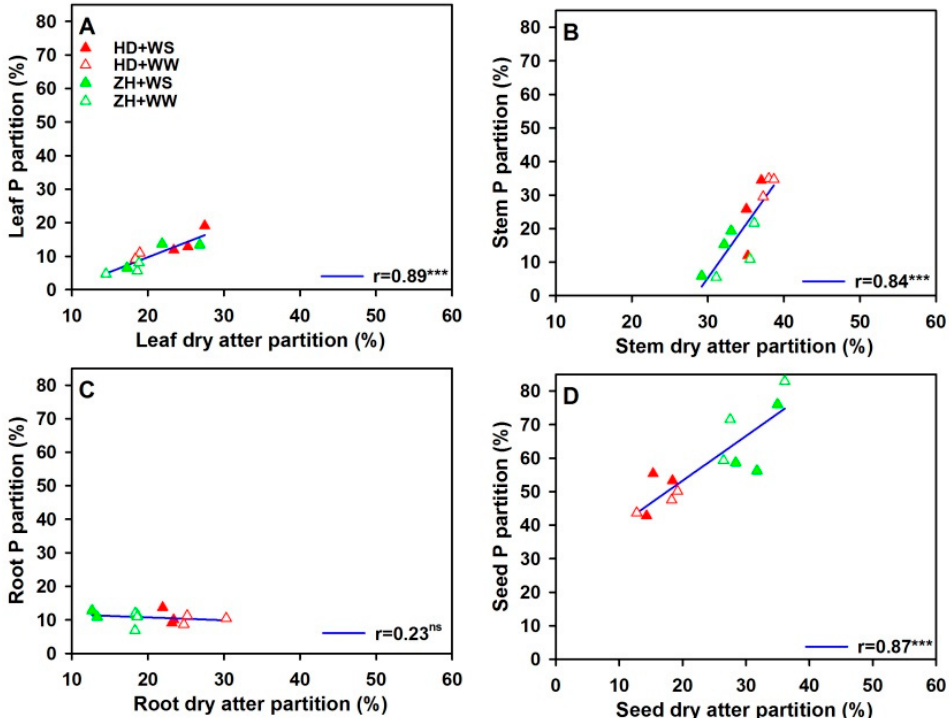
Figure 5. The relationship between ( A ) leaf dry matter partition and leaf P partitioning, ( B ) stem dry matter partition and root P partitioning, ( C ) root dry matter partition and stem P partitioning, and ( D ) seed dry matter partition and seed P partitioning at maturity under two water regimes (well-watered (WW) and cyclic water stress (WS)) and three P rates (0 (P0), 60 (P60), and 120 (P120) mg P kg –1 dry soil). n.s., not significant, *** p < 0.001.